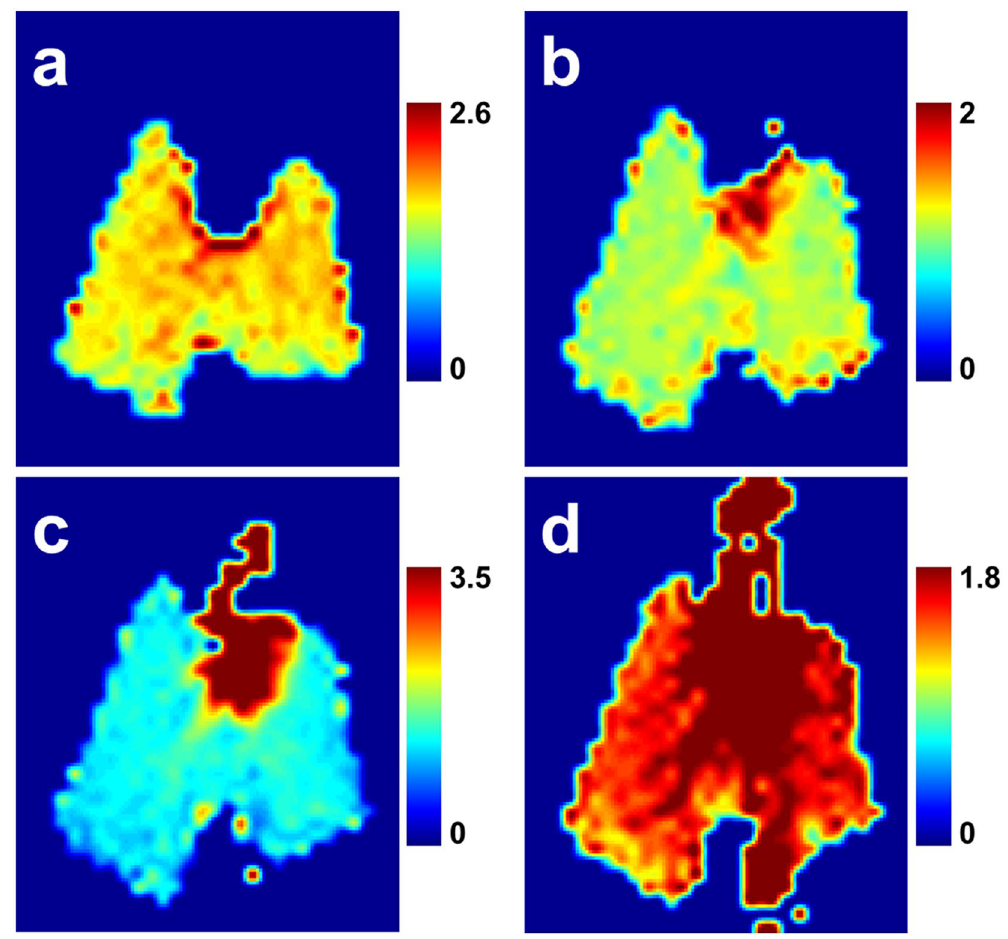
Figure 3. Select DP flip angle and repetition time combinations scaled to illustrate various stages of xenon gas transport during the breathing process. ( a ) Late-stage filling of veins near the heart with xenon-saturated blood Full delineation of gas transport through the venous and arterial vessels proximal to the heart (40°, TR 150 ms vs. TR 25 ms).